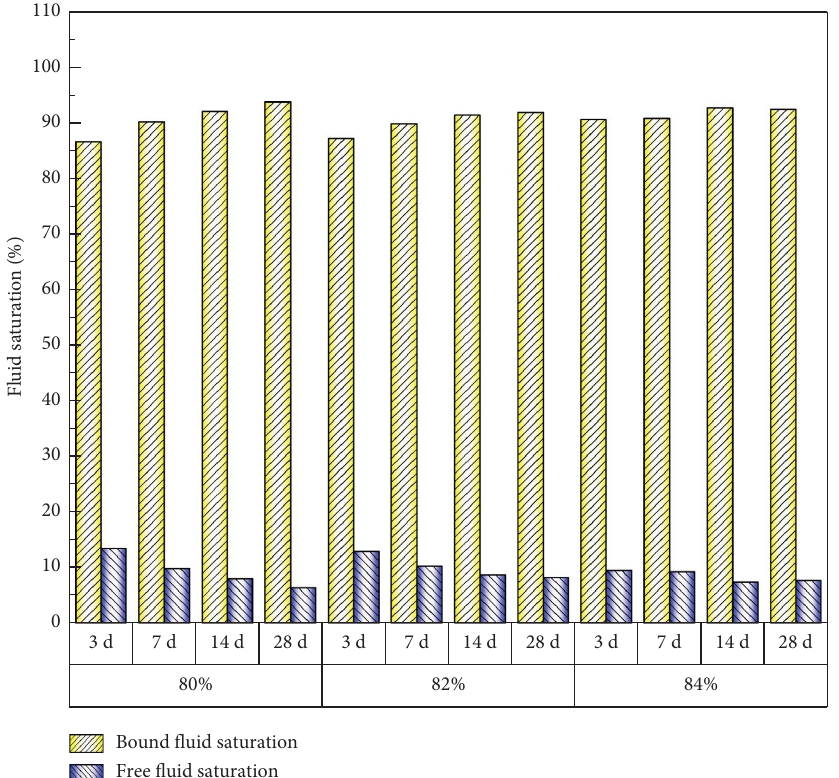
Figure 10: Free fuid saturation and bound fuid saturation of CGGCFB at diferent ages and mass